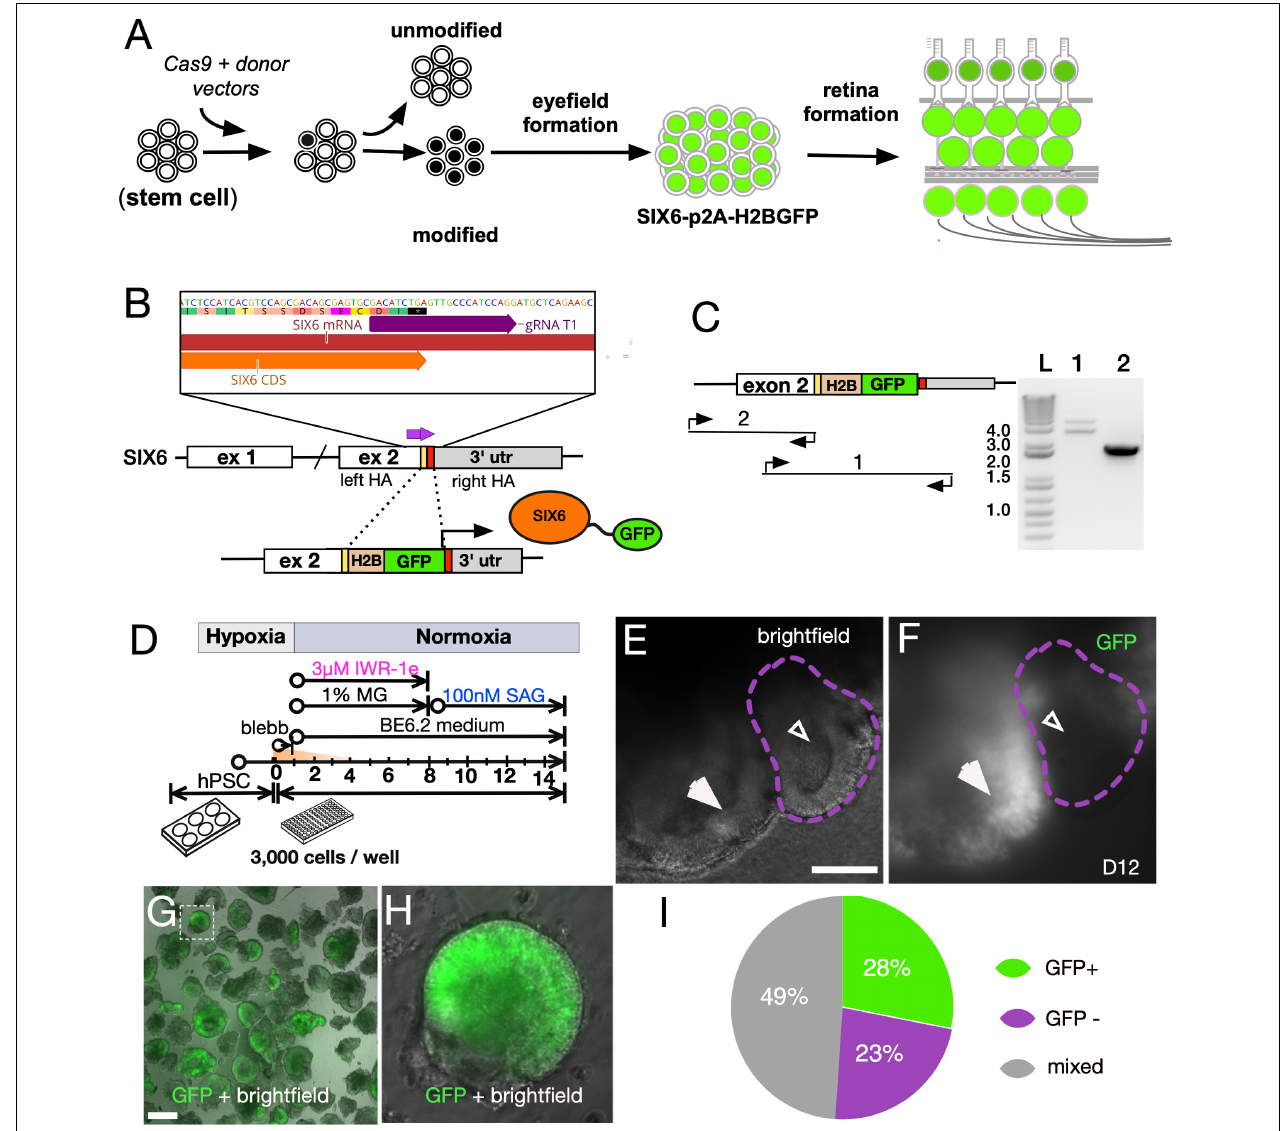
FIGURE 1 | Directed differentiationdependence of SIX6 reporter PSCs into 3D retinas to validate reporter expression. (A) Schematic of stem cells modified with a SIX6-GFP reporter. (B) CRISPR/Cas9 targeting with a guide RNA spanning the stop site of the SIX6 gene. Donor fragment the H2B-GFP expression cassette with homology arms to facilitate homology directed repair (HDR). (C) Verification of the GFP cassette insertion by PCR amplification of genomic DNA with oligonucleotides that 1- flank the GFP insert (detects homo- and heterozygosity), and 2- flank the left arm and within the insert (detects insert). A 1Kb + DNA ladder (Invitrogen) was used for DNA band size resolution. (D) The experimental approach used for reporter validation. (E) Bright-field images and (F) reporter expression in some, but not all, vesicles at day 12. Large arrows (E,F) indicate GFP + vesicles while smaller arrows indicate GFP - vesicles. (G) Neural vesicles excised at D12 were live imaged for GFP fluorescence. µ m (H) A magnified image from panel (G) (squared box) with GFP fluorescence overlaid onto a bright-field image. (I) Percentage of vesicles that exhibit GFP +, GFP – or mixed expression patterns following manual excision. Scale bars = (E) 175 µ m, (G) 300 µ